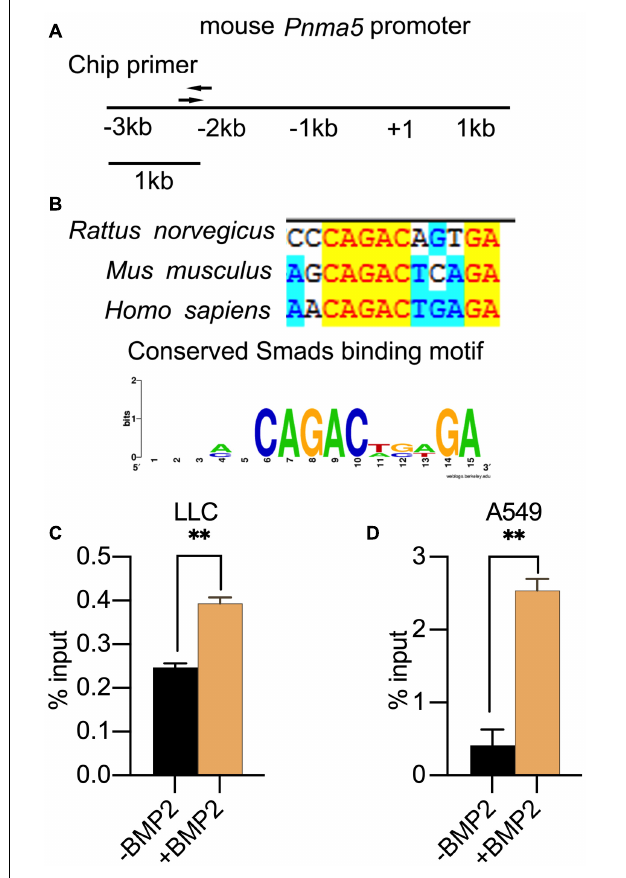
FIGURE 3 | PNMA5 was the direct target of BMP2 signaling. (A) The DNA sites where the ChIP primers were designed at the PNMA5 promoter. (B) The “CAGAC” element in the PNMA5 promote is conserved across species. The “CAGAC” Smad1/5 binding motif across species was analyzed by WebLogo. (C) ChIP assay was performed in LLC cells treated with or without BMP2 for 6 h using the Smad1/5 antibodies. The immunoprecipitated DNA was amplified by quantitative real-time PCR with the primers designed in (A) ** P < 0.01. (D) ChIP assay was performed in A549 cells treated with or without BMP2 for 6 h using Smad1/5 antibodies. The immunoprecipitated DNA was amplified by quantitative real-time PCR with the primers designed in (A) ** P <